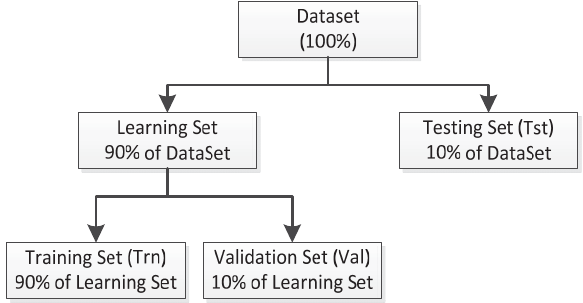
Fig. 1. Tenfold cross-validation